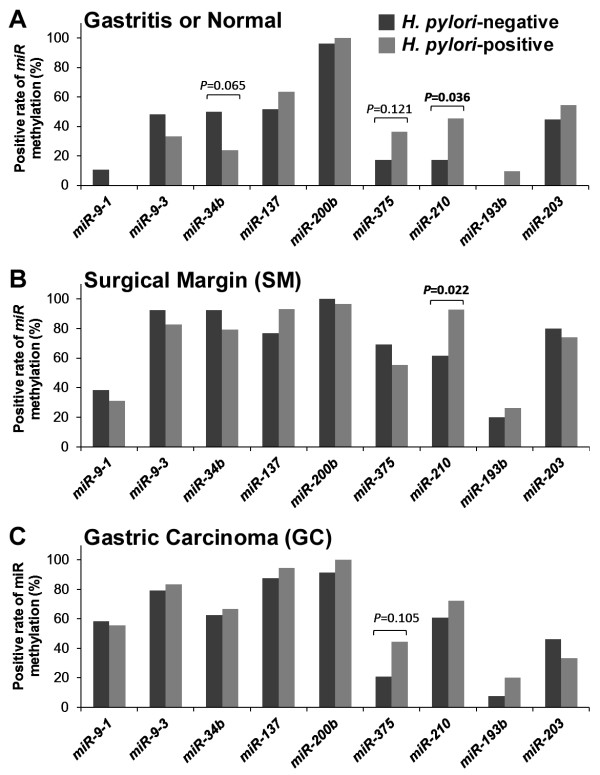
Comparison of miR methylation in various gastric mucosa samples with and without existence of H. pylori. (A) Normal or gastritis biopsies from control outpatients without malignant disease; (B and C) Surgical margin and tumor samples from patients with gastric carcinoma, respectively; H. pylori-specific 23 S rDNA was detected by PCR.